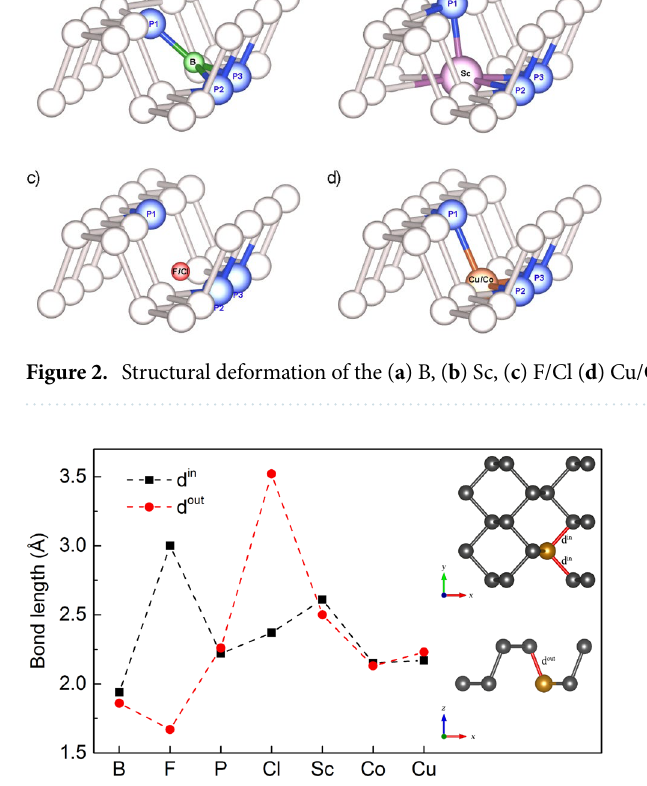
Figure 3. Bond length between P and dopant atom in the xy plane ( d phosphorene (P) substitutionally doped by B, F, Cl, Sc, Co and Cu